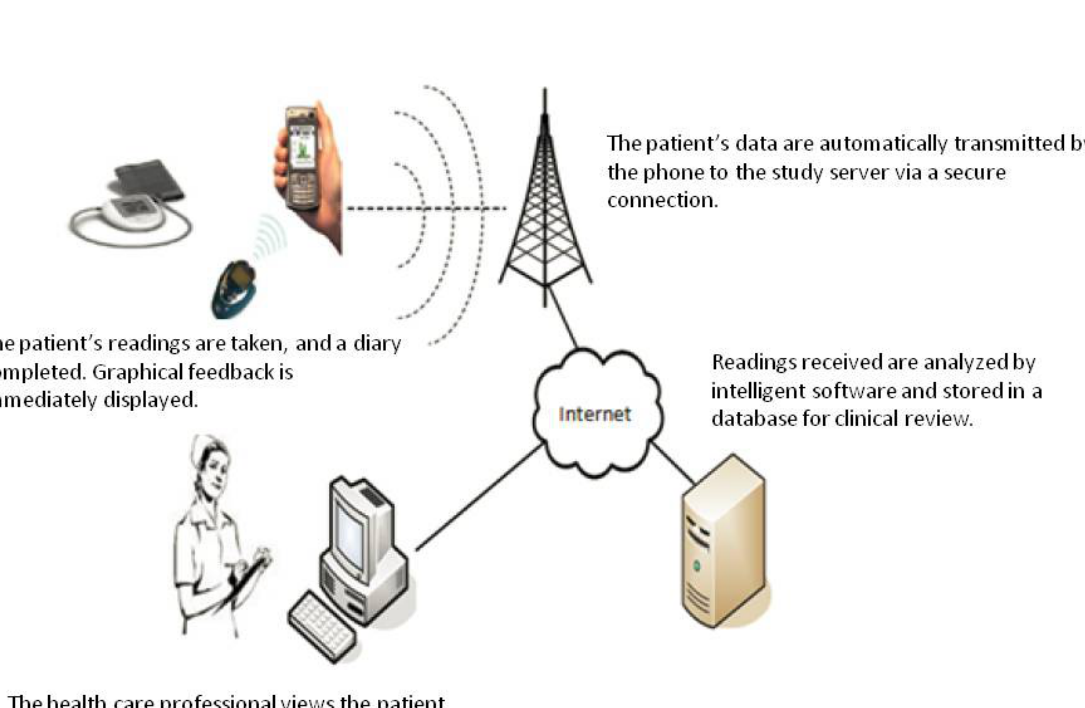
Figure 1. Architecture of the MTH system